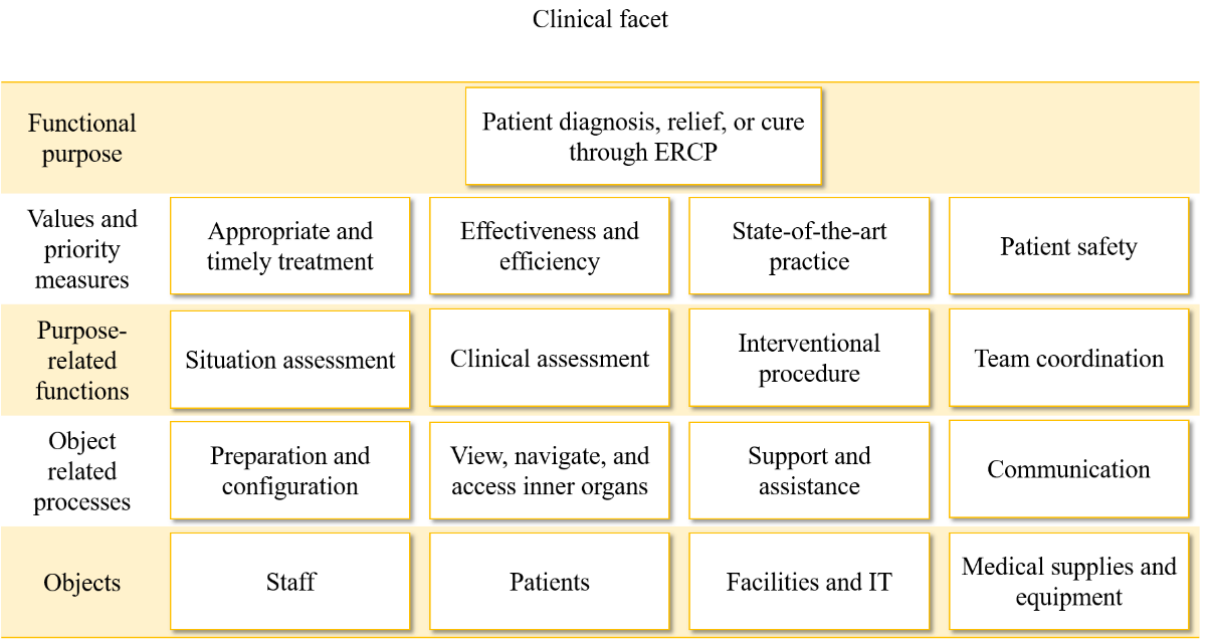
Figure 4. Abstraction hierarchy, clinical